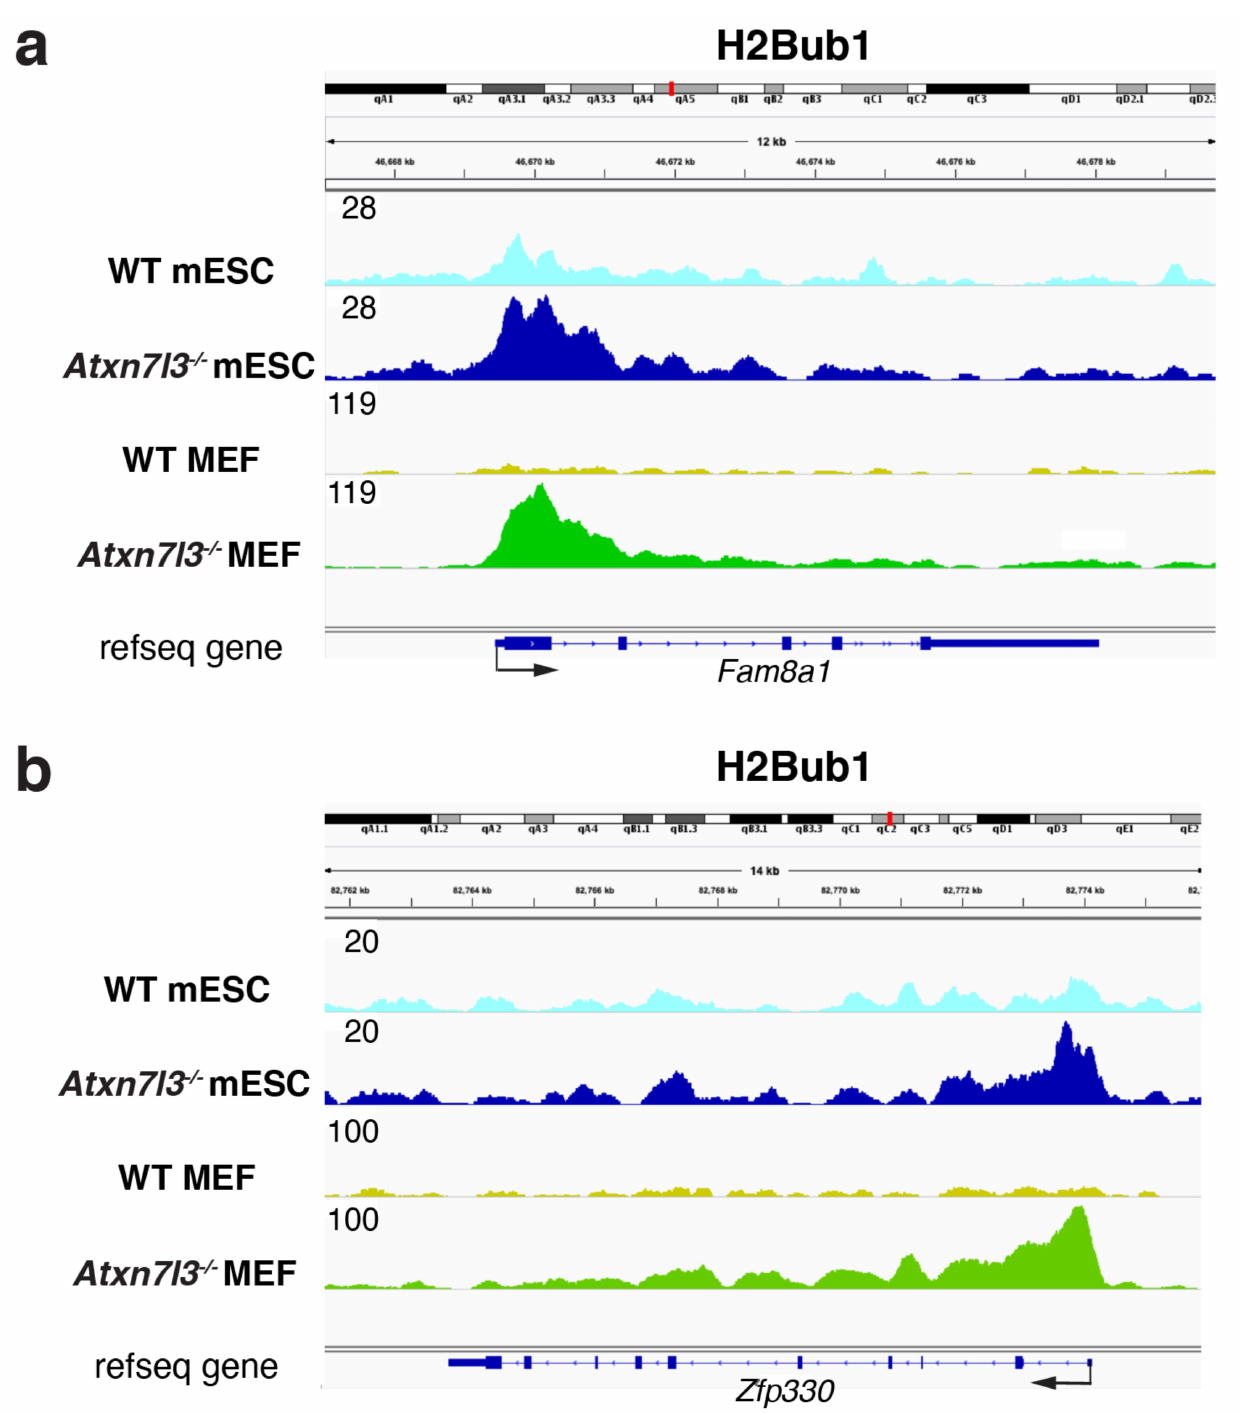
Figure 2. Histone H2Bub1 levels increase strongly in the gene bodies of both Atxn7l3 − / − mESCs and Atxn7l3 − / − MEFs. ( a , b ) Depletion of the SAGA DUB subunit, ATXN7L3, results in retention of H2Bub1 by around three to five-fold in mESCs, and around eight to ten-fold in MEFs compared to the corresponding wild type (WT) cells. Representative IGV genomic snapshots of H2Bub1-binding profiles are shown at two selected genes ( Fam8a1 and Zfp330 ), re-analyzed from GSE153584 [34]. Direction of the transcription is indicated by arrows. Group scaled tag densities on each gene either in mESCs, or in MEFs, are indicated on the